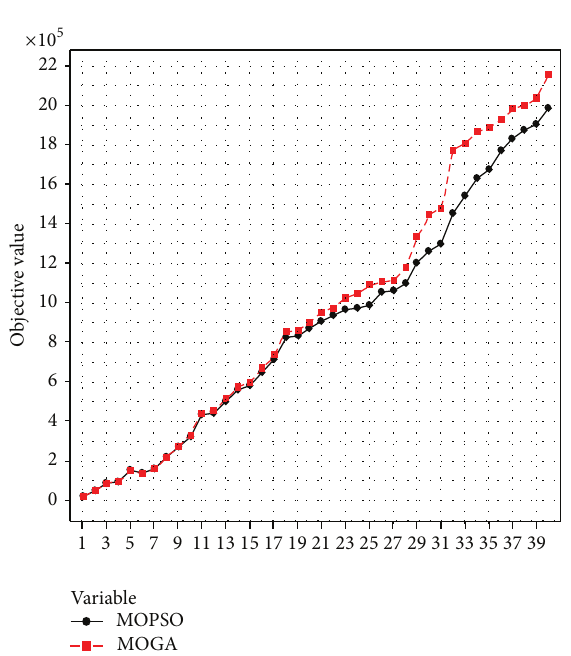
Figure 6: The pictorial representation of the performances of the